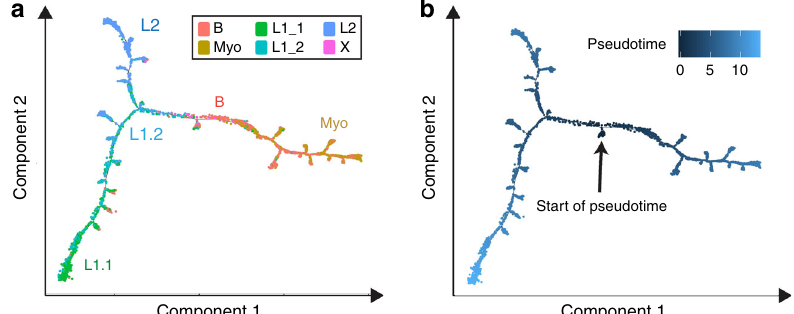
Fig. 6 Reconstruction of differentiation and relation of cell states to breast cancer subtypes. a Monocle-generated pseudotemporal trajectory of a subsampled population of cells ( n = 4000) from four individuals analyzed using droplet-mediated scRNAseq is shown colored by cell state designation. b Pseudotime is shown colored in a gradient from dark to light blue and start of pseudotime is indicated. See Supplementary Fig. 6 for summary list of discovered cell states, Monocle analysis of micro fl uidics-enabled scRNAseq results and gene scoring for breast